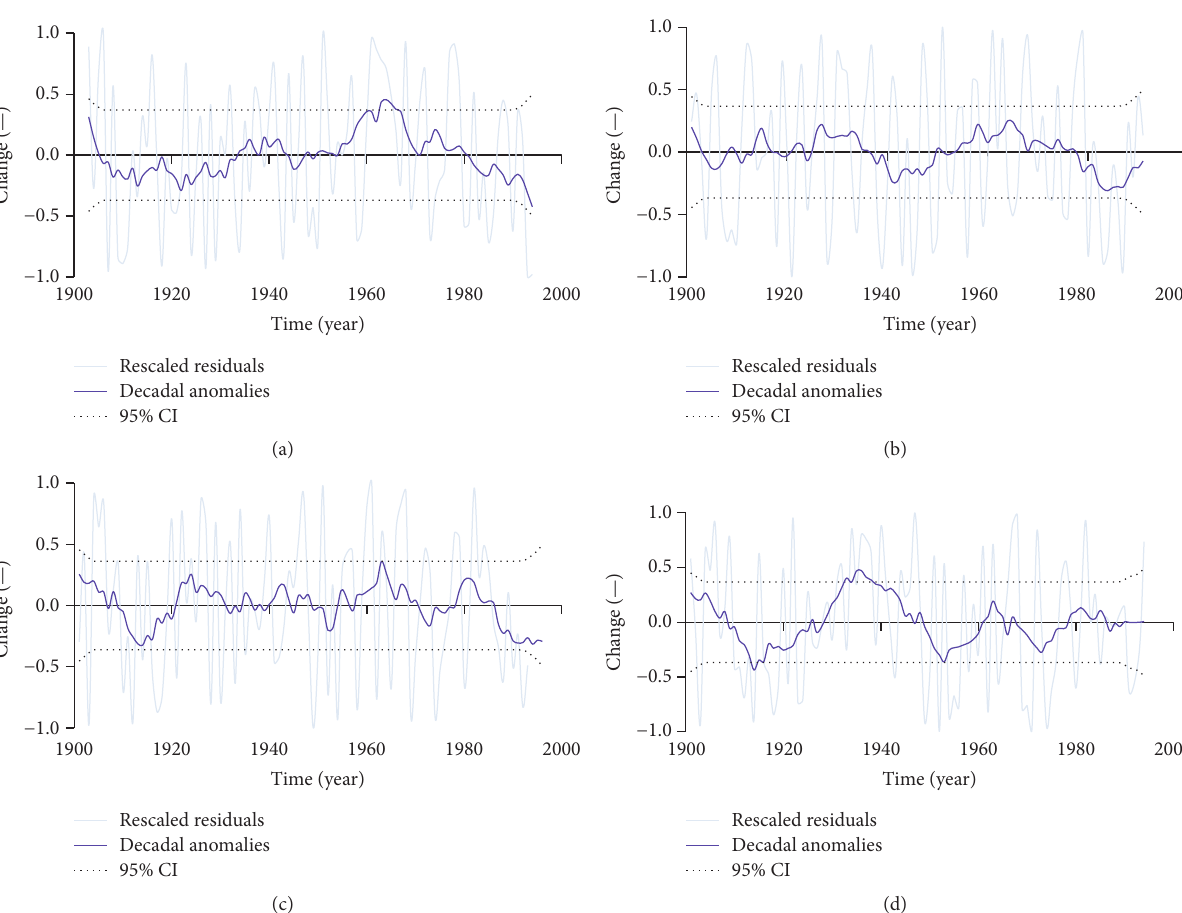
both trend directions and magnitudes in terms of widths of their 95% CI can be seen to vary from station to